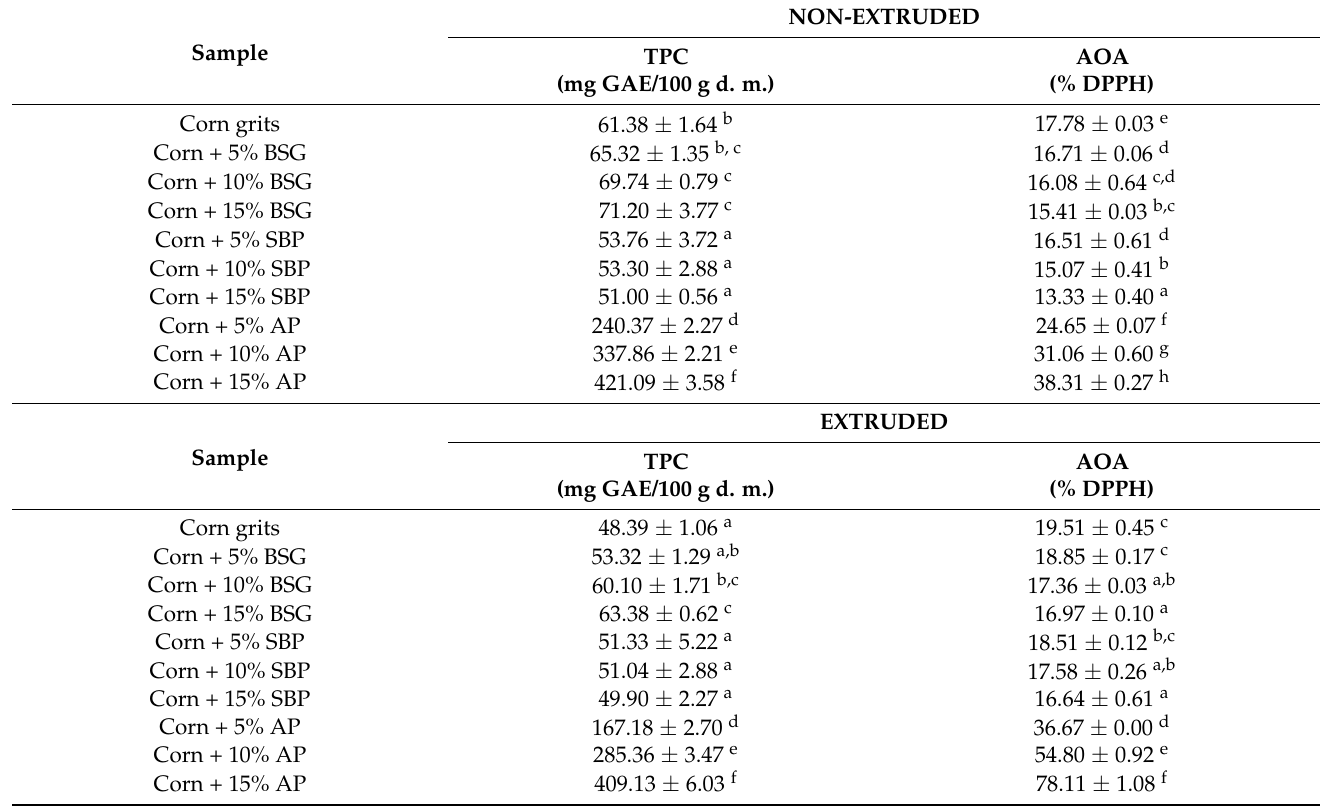
Table 4. Total phenolic content and antioxidant activity of non-extruded and extruded